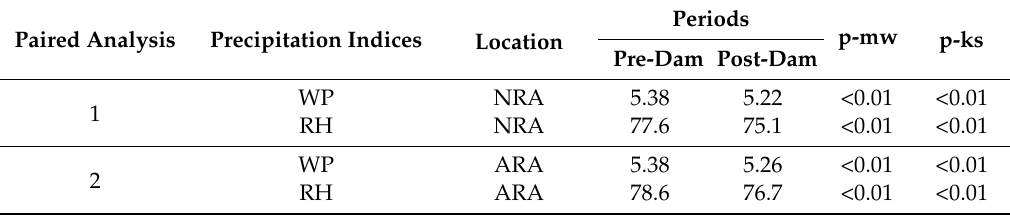
Table 10. Statistical difference tests for the mean and distribution in the RH (%) and WP (hPa) at the same locations for the different periods.